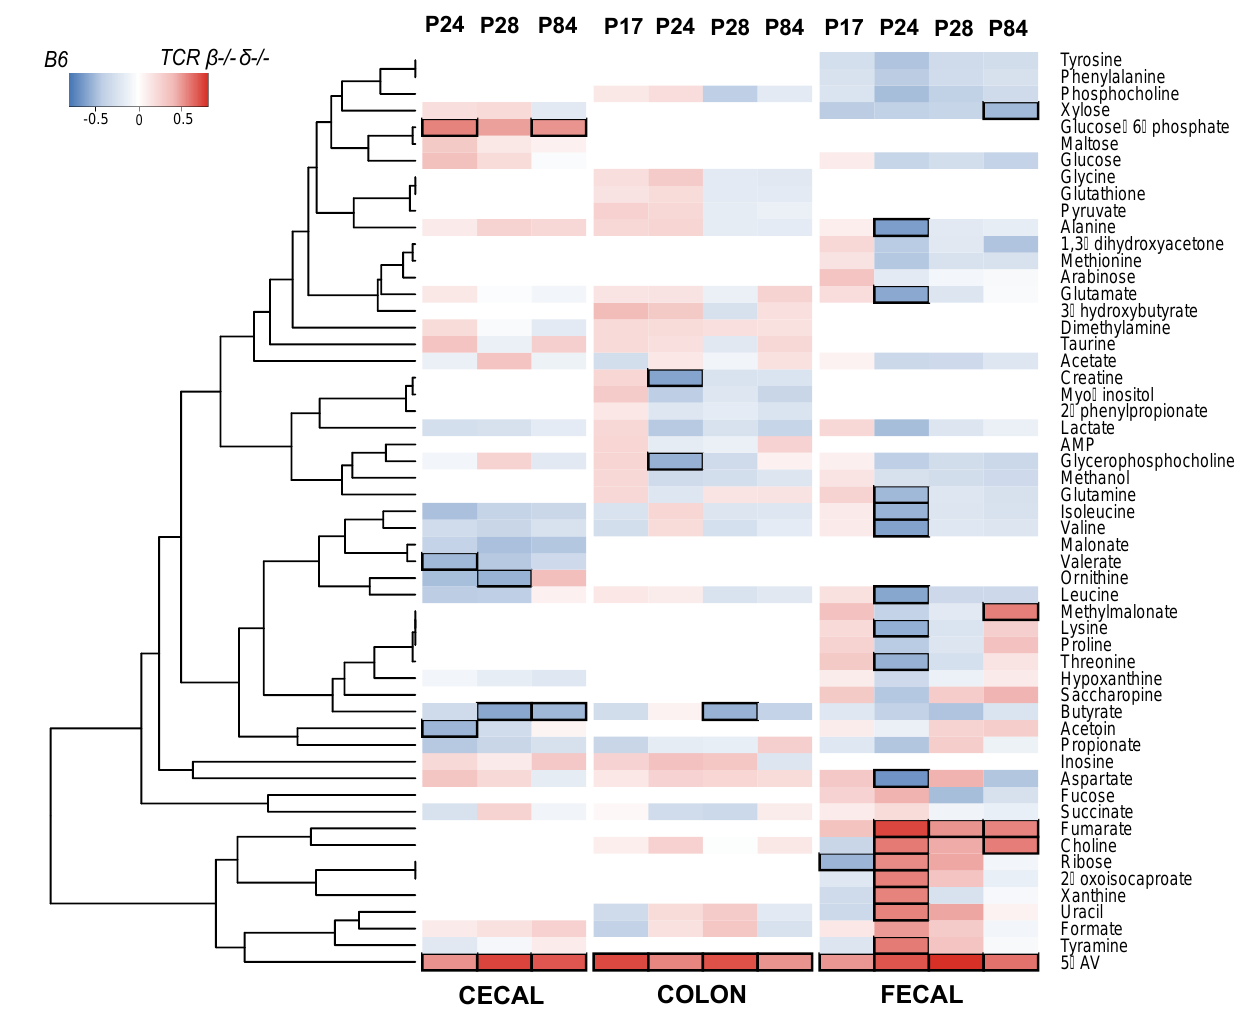
Figure 3. Metabolic variation of cecal, colon and fecal samples associated with genotype. The heatmap illustrates the correlation coefficient ® obtained from OPLS models at individual timepoints for cecal, colon and fecal samples. Metabolites overrepresented in (C57Bl/6) B6 mice are shown in blue, those overrepresented in T cell receptor double knock out ( TCR β– / –δ– / – ) mice are shown in red. Black squares indicate correlations with r > │ 0.5 │ .